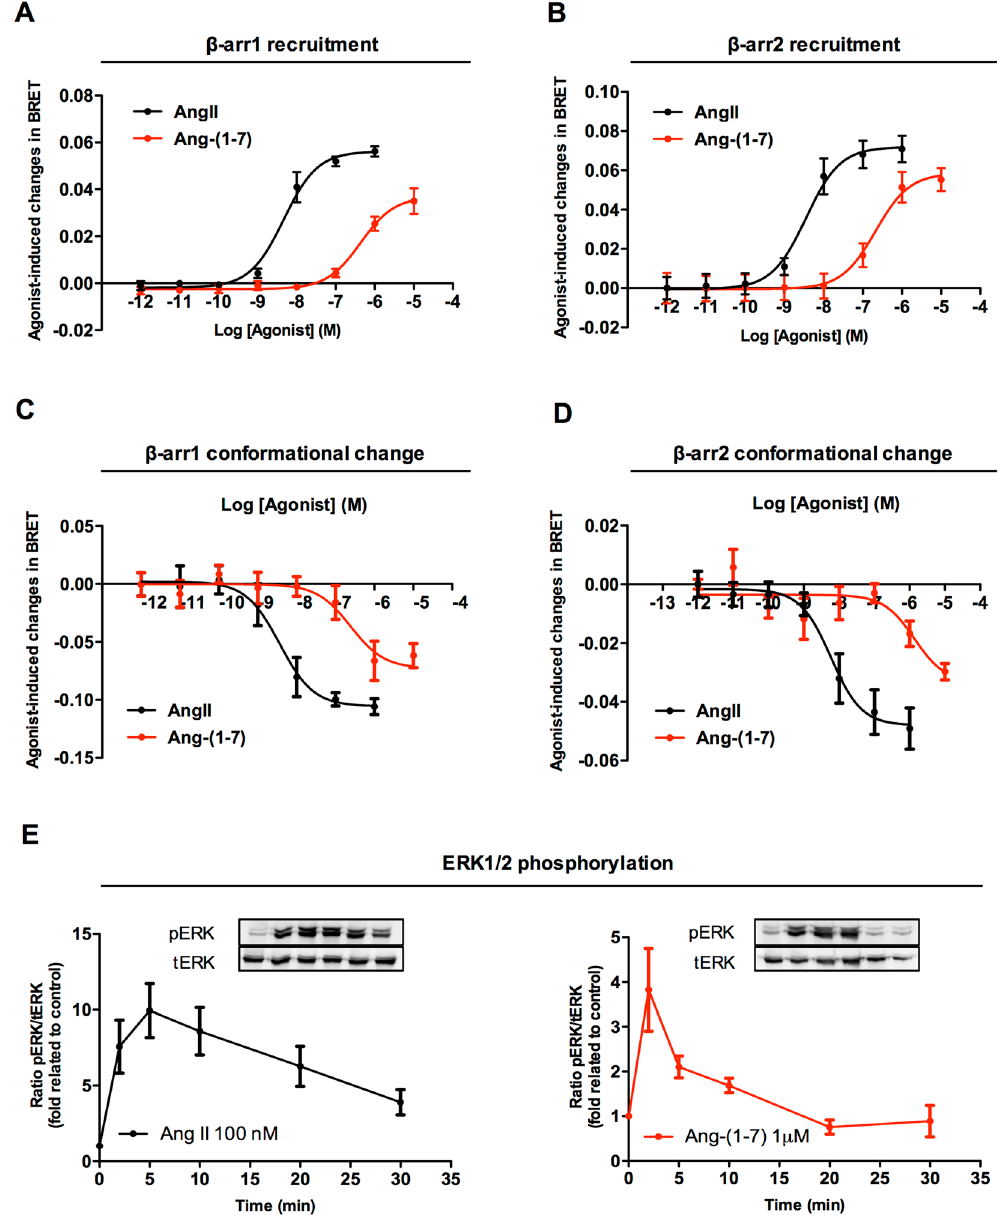
Figure 2. Comparative analyses of Ang-(1-7) and AngII acting at the AT 1 receptor to induce β -arrestins recruitment, β -arrestins conformational changes, and ERK1/2 phosphorylation. Concentration-response curves for Ang-(1-7) and AngII were generated to evaluate the recruitment of β -arrestin 1 ( A ) or β -arrestin 2 ( B ) to the AT1R by BRET. The abilities of the ligands to trigger β -arrestin activation, as evaluated by conformational rearrangements of β -arrestin 1 ( C ) or β -arrestin 2 ( D ), were monitored by intramolecular BRET as described in Methods. Kinetics of ERK1/2 phosphorylation after stimulation with 100 nM AngII or 1 μ M Ang-(1-7) ( E ). Data were generated from at least 4 independent experiments. Blots were cropped for conciseness of the presentation; full-length blots are presented in Supplementary Figure